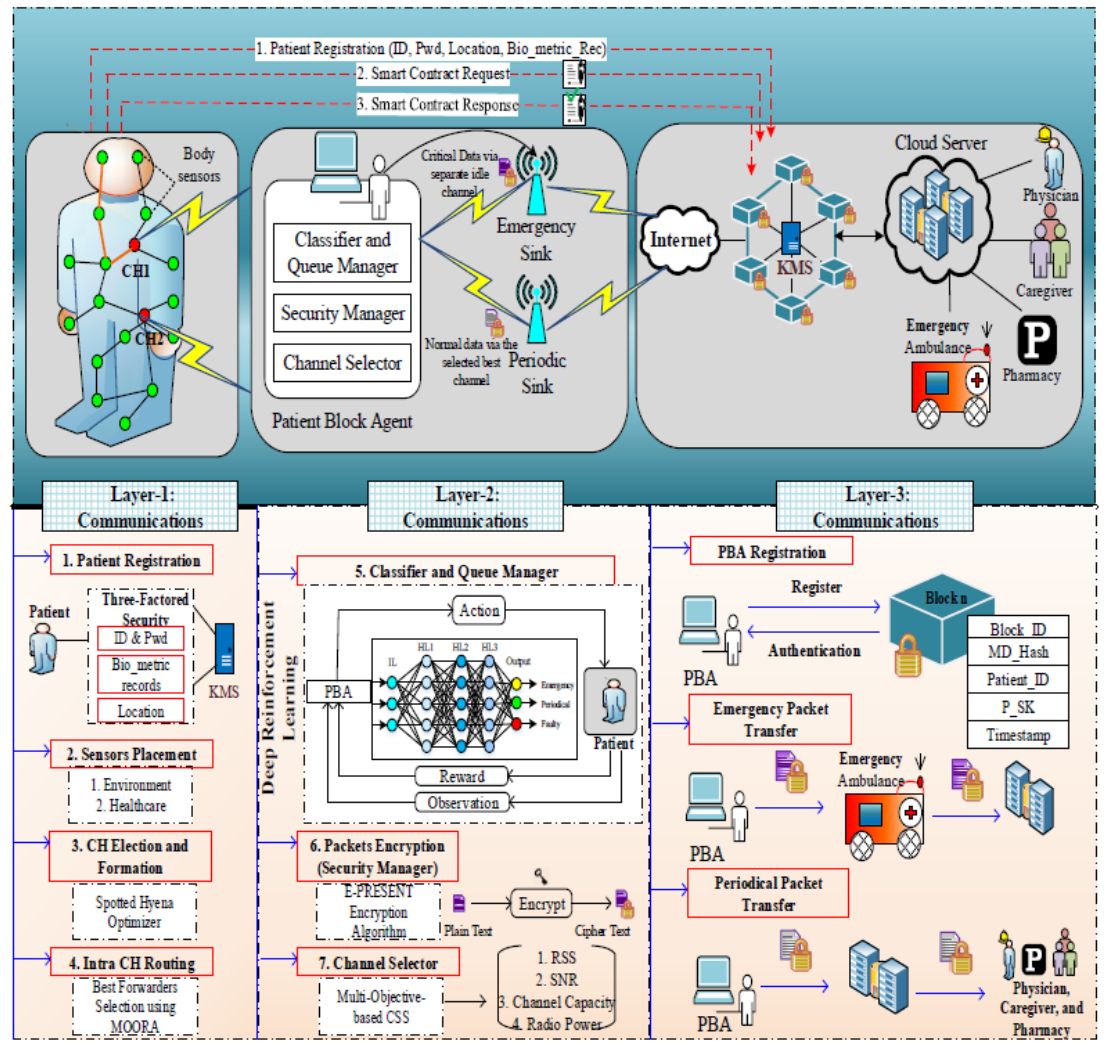
Figure 1. System